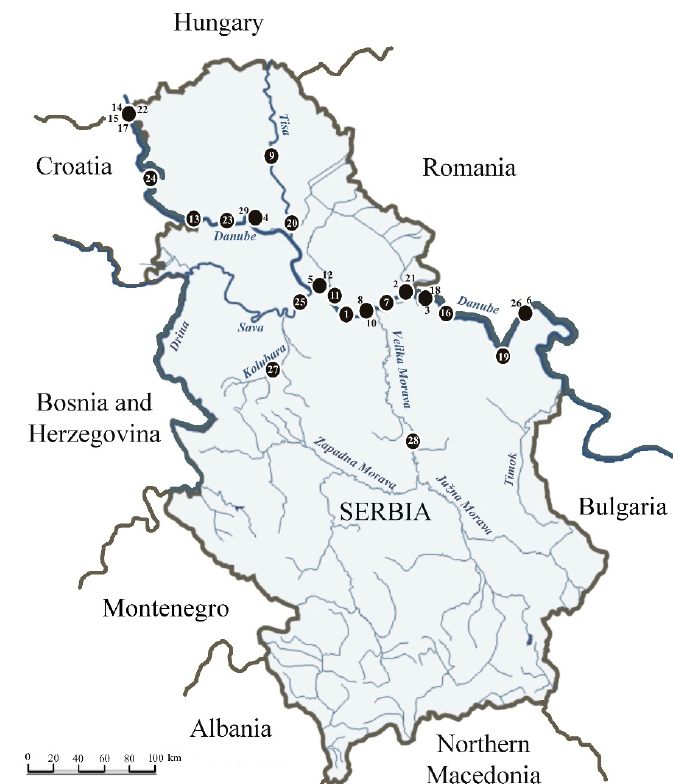
Figure 1. Locations of initial findings of allochthonous macroinvertebrate species along the rivers in Serbia. Numbers correspond to the species as listed in the Table 1.